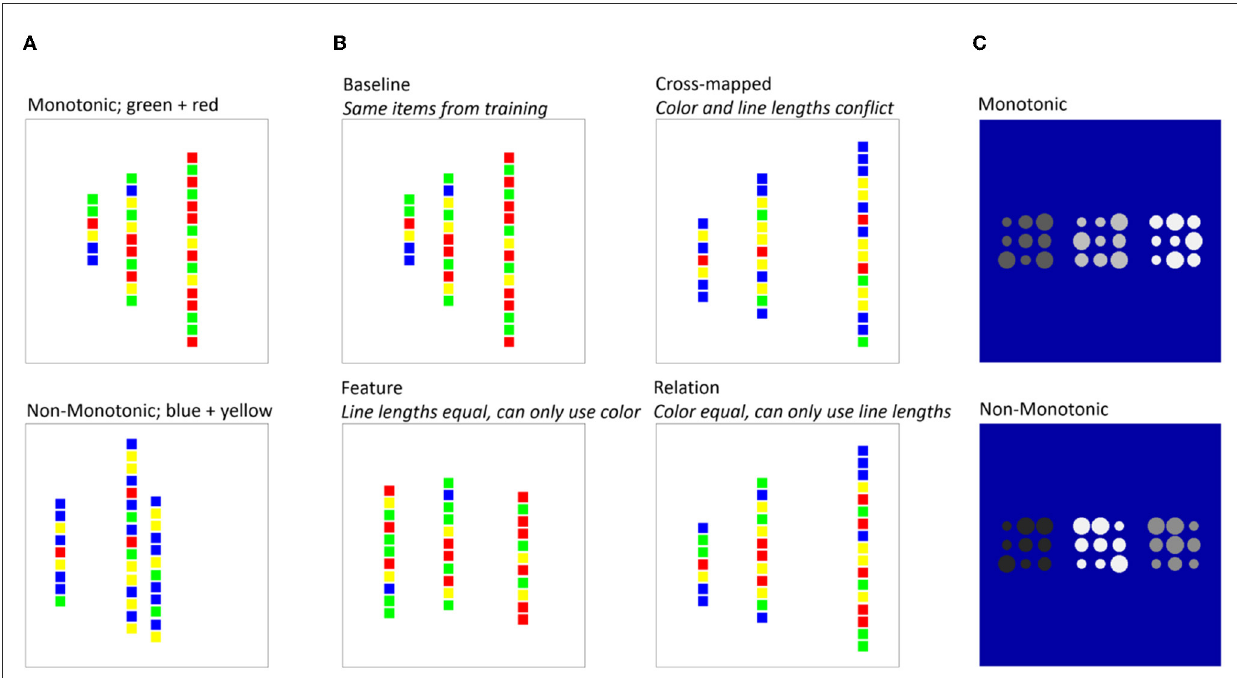
FIGURE1 Example stimuli from a relational categorization experiment (Goldwater et al., 2018). (A) Participants are trained on exemplars that abide by a relational spatial rule (line lengths change monotonically for one category and non-monotonically for the other) but also have color proportions that correlate with category membership. (B) Participants are given “near” transfer test items that possess spatial relations and/or color proportions consistent with one or other category. (C) Participants are given a new “far transfer” categorization task in which a similar monotonicity rule applies, this time based on the shades of gray of the component